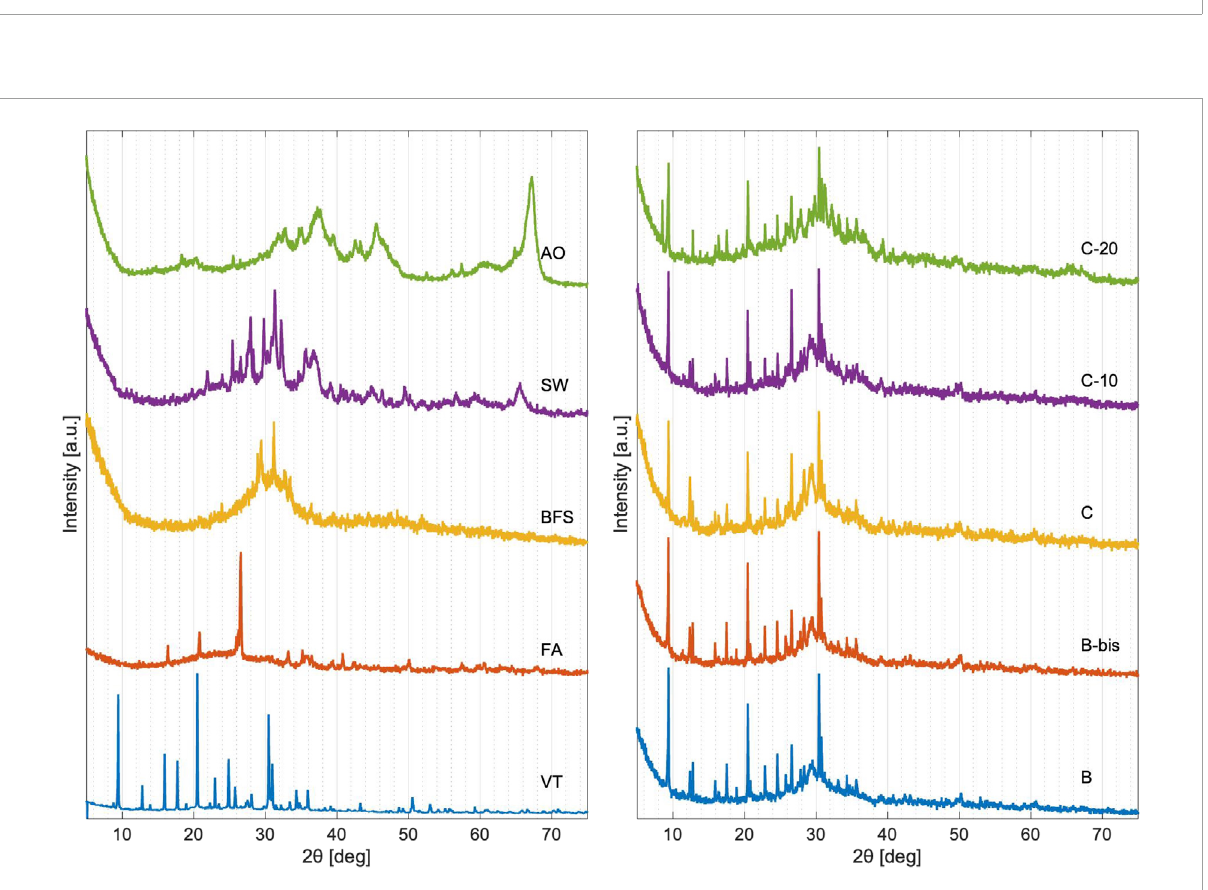
FIGURE 3 Diffraction patterns of precursors (left) and geopolymeric matrices